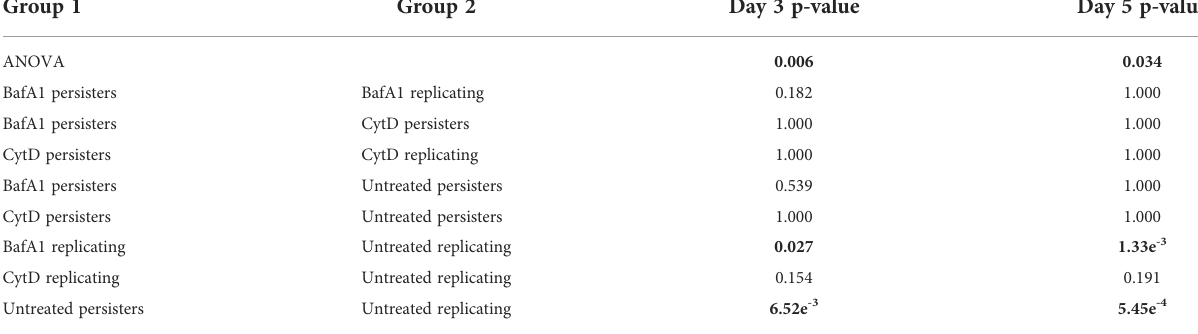
TABLE 3 Comparison of bacterial numbers at day 3 and day